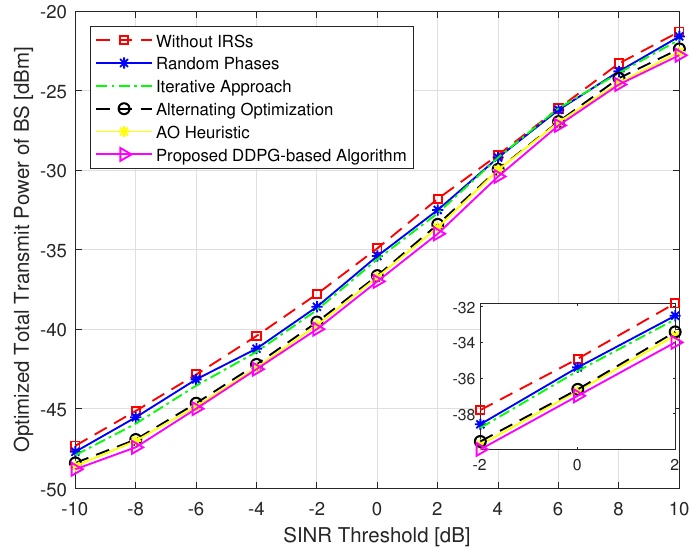
Figure 12. Optimized total transmit power versus SINR threshold under different schemes.